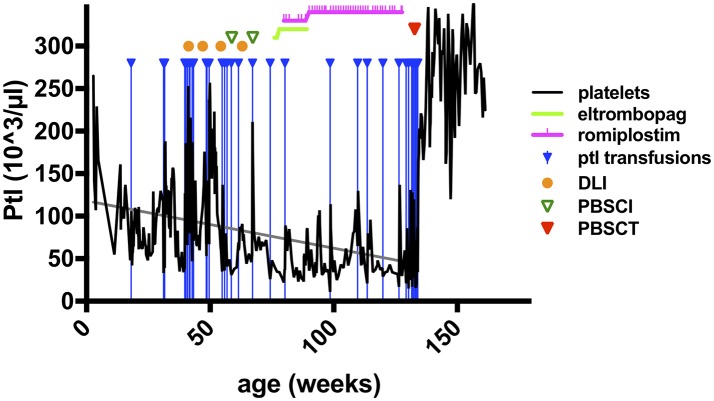
Platelet counts and therapeutic interventions in a patient with WIP deficiency. The course of platelet counts of the patient of pedigree C (Table 1, right column) is shown as black solid line (x1,000/μl) in weeks of life (x-axis). Treatment interventions are shown in the figure legend as indicated. Doses of cell transfer and stem cell transplantation are stated in the main text. Ptl, platelets; DLI, donor lymphocyte infusions; PBSCI, peripheral stem cell infusion (without prior conditioning treatment); PSCT, peripheral stem cell transplantation (HSCT after conditioning pretreatment as described in the main text).